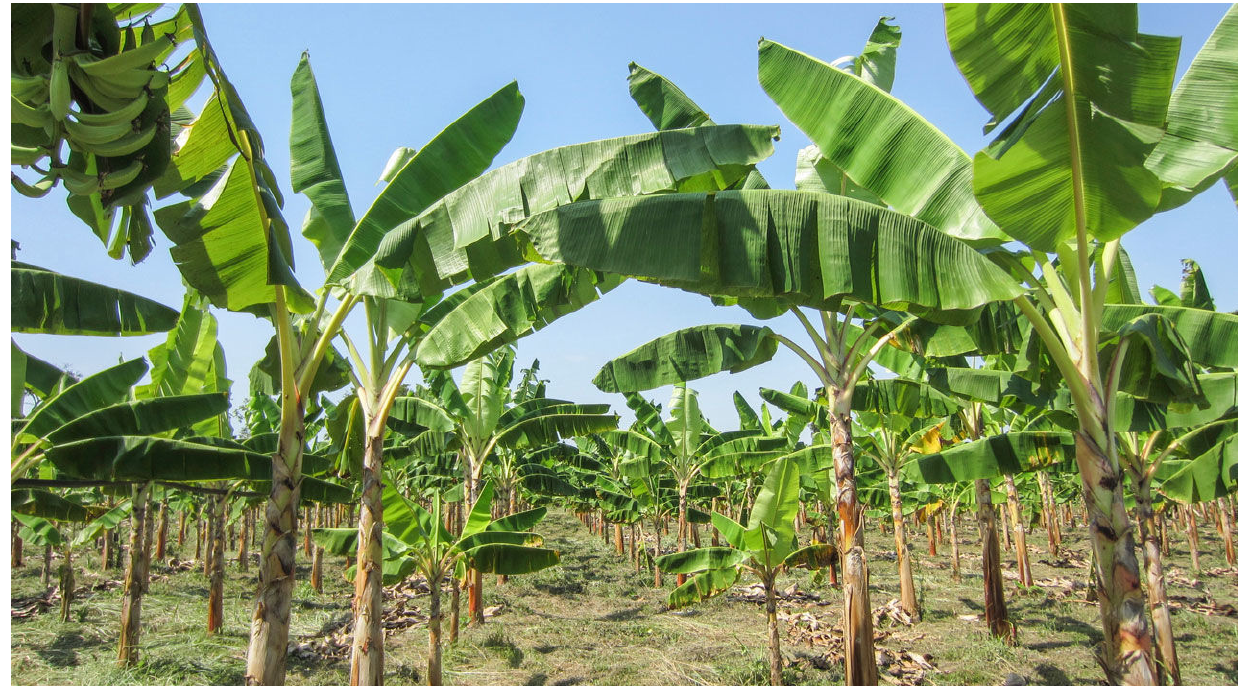
Figure 1. Banana Musa sp. plantation.